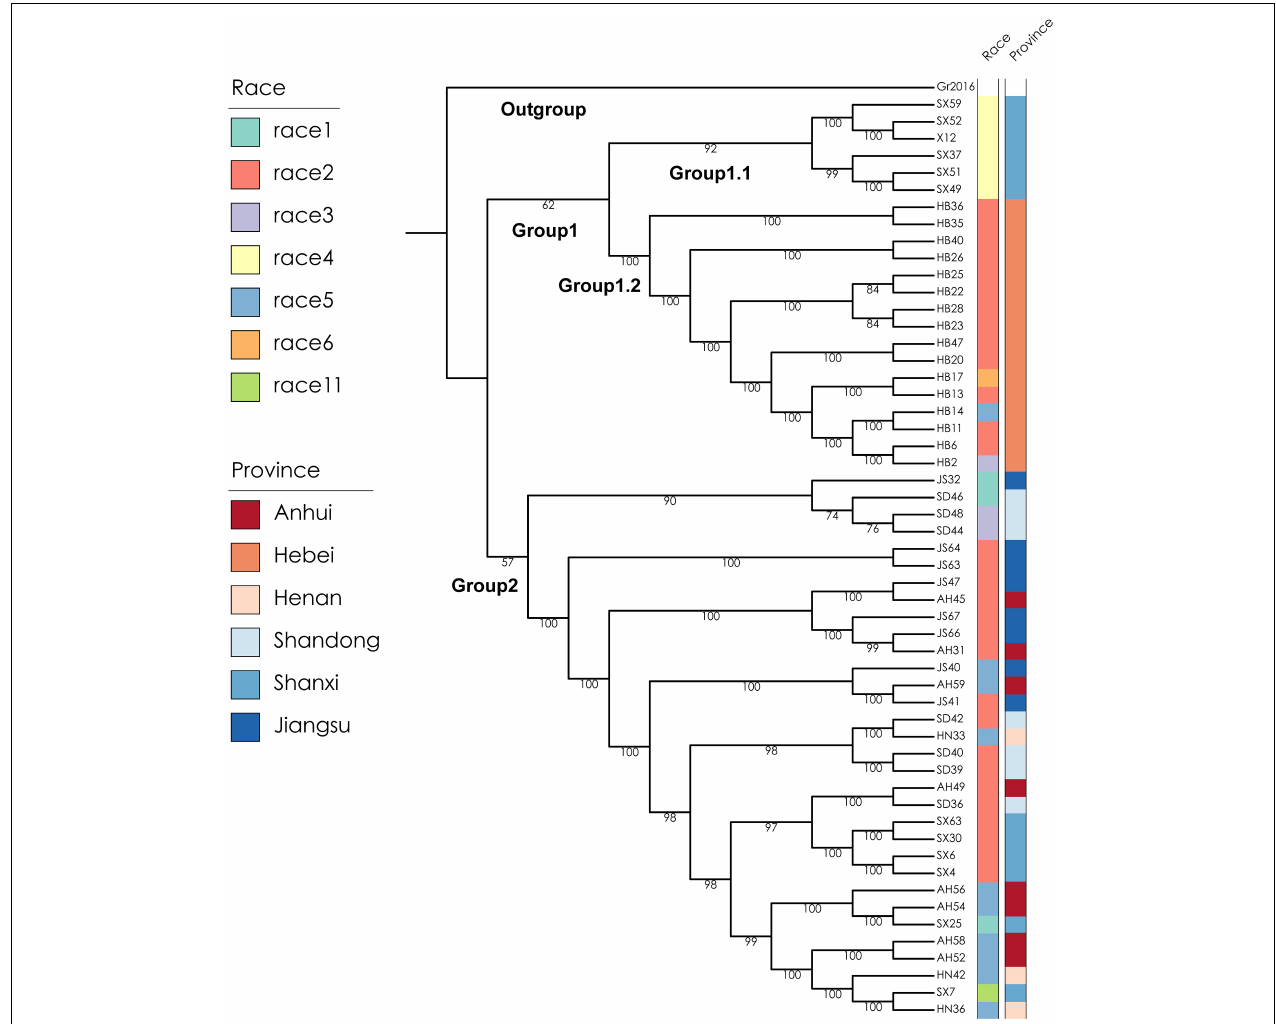
FIGURE 2 | Maximum-likelihood (ML) phylogenetic tree of 54 populations of the SCN from the Huang-Huai Valleys in China. The two capital letters represent the abbreviations of the provinces where the soil samples were collected, followed by the sample number. AH, JS, SD, HN, HB, and SX refer to Anhui, Jiangsu, Shandong, Henan, Hebei, and Shanxi provinces, respectively. The left color bar on the right is showing the corresponding race number and the right color bar the collection province. Globodera rostochiensis , Gr2016, is used as outgroup species (Akker et al., 2016).